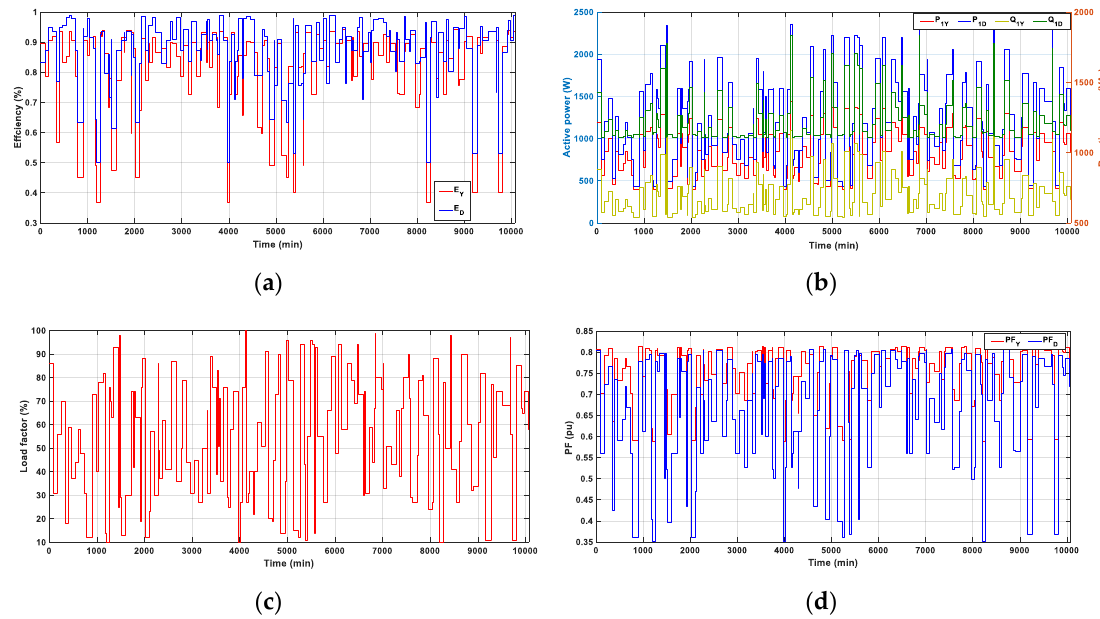
Figure 13. Weekly study of IM 2.2 kW (IMEMSL #3): ( a ) Energy e ffi ciency; ( b ) Active and reactive power; ( c ) Load factor; ( d ) Power